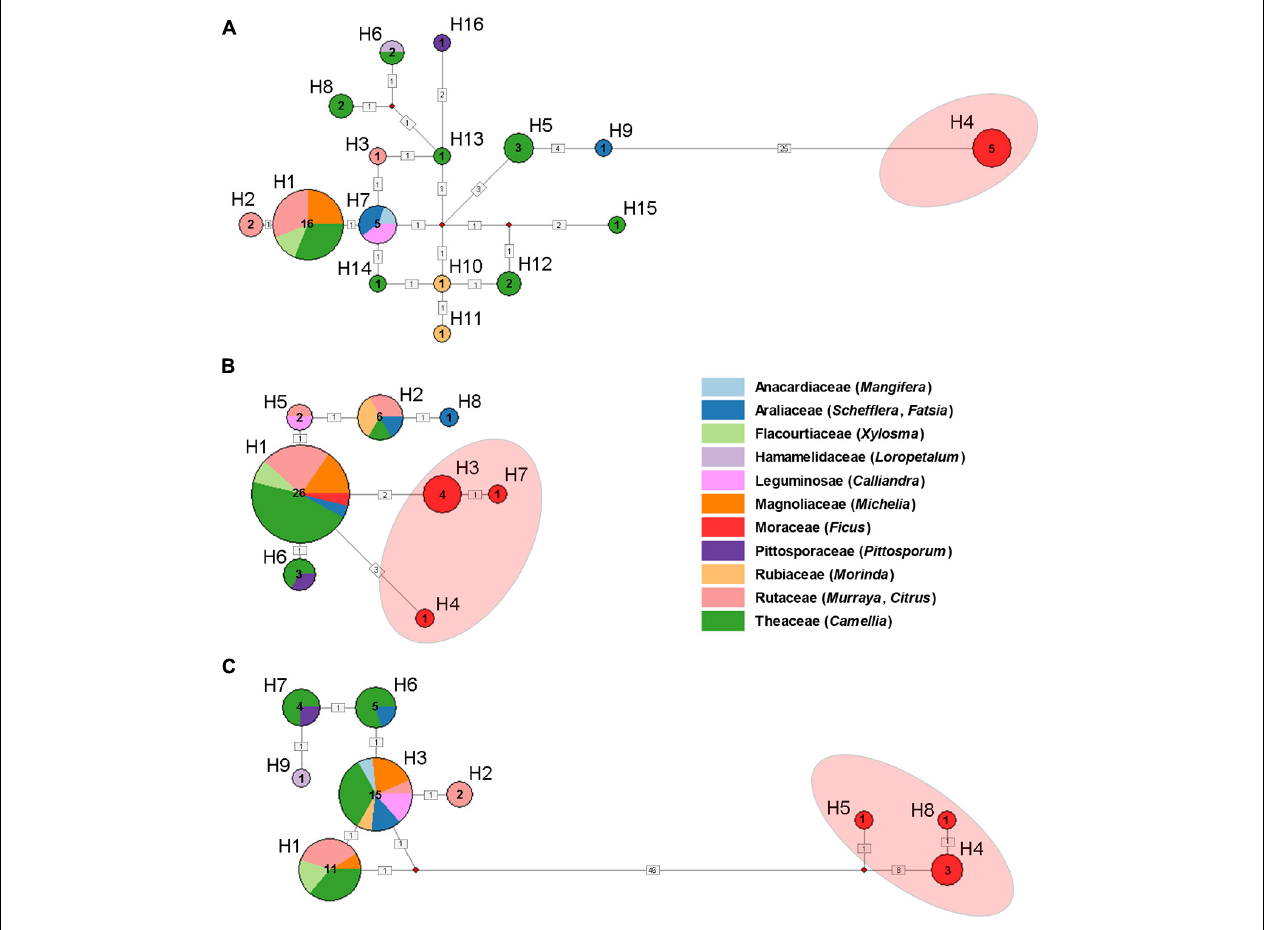
FIGURE 2 | Haplotype network of Aphis aurantii populations based on COI + Cytb (A) , EF-1 α (B) and gnd and 16S (C) . Numbers near the circle indicate haplotype numbers. Sample numbers and host plants (in different color) of haplotypes are annotated in the circles. The numbers in the black square indicate number of mutations. The red shading on the haplotype network represents Ficus